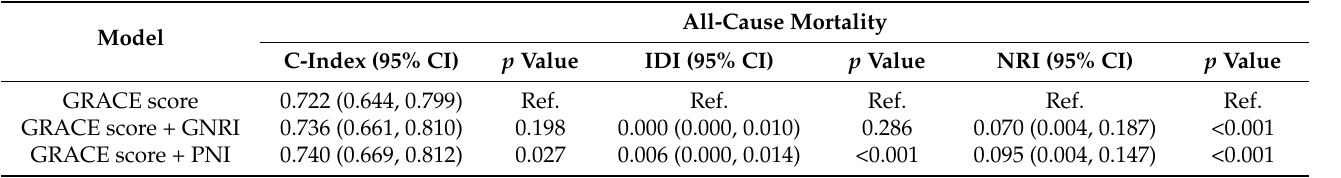
Table 4. Model performance after the addition of the nutritional indices to the GRACE risk score for predicting all-cause